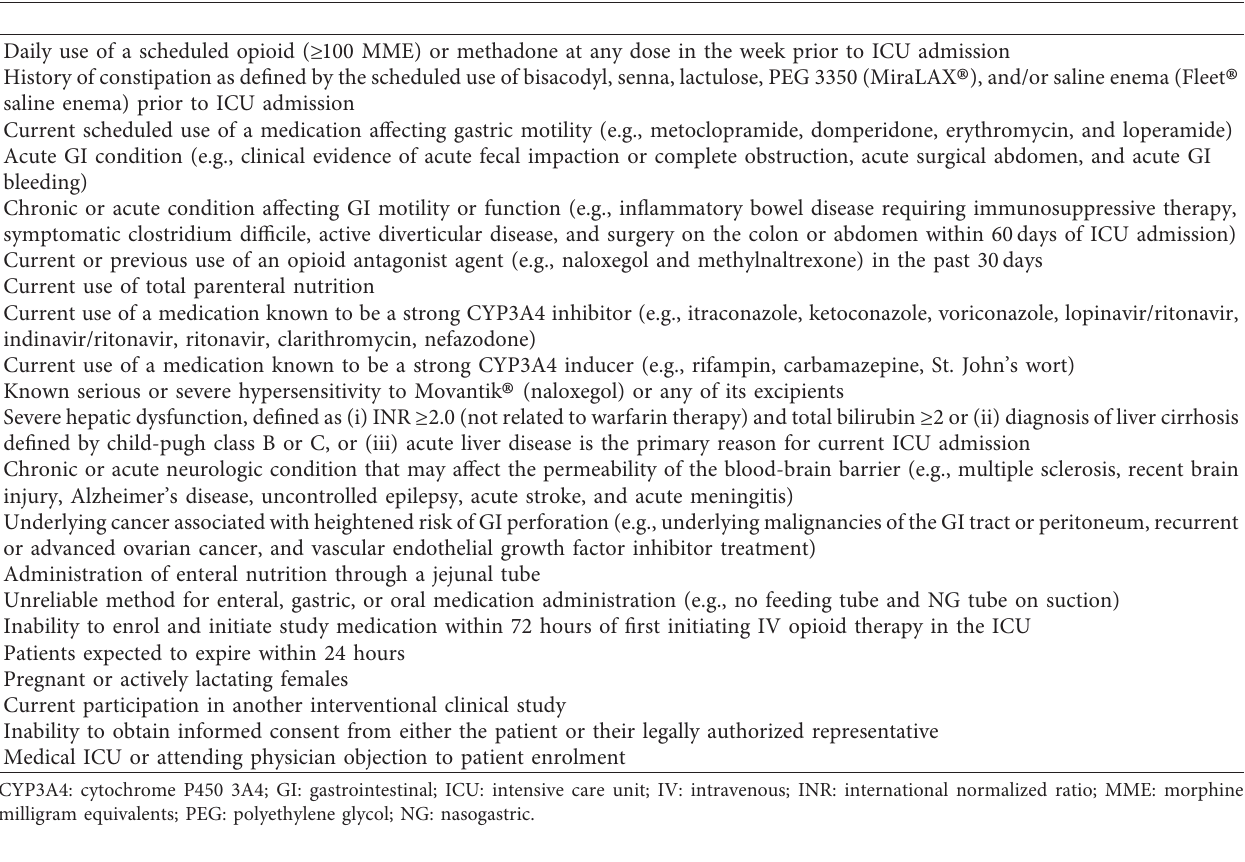
Table 1: Study exclusion